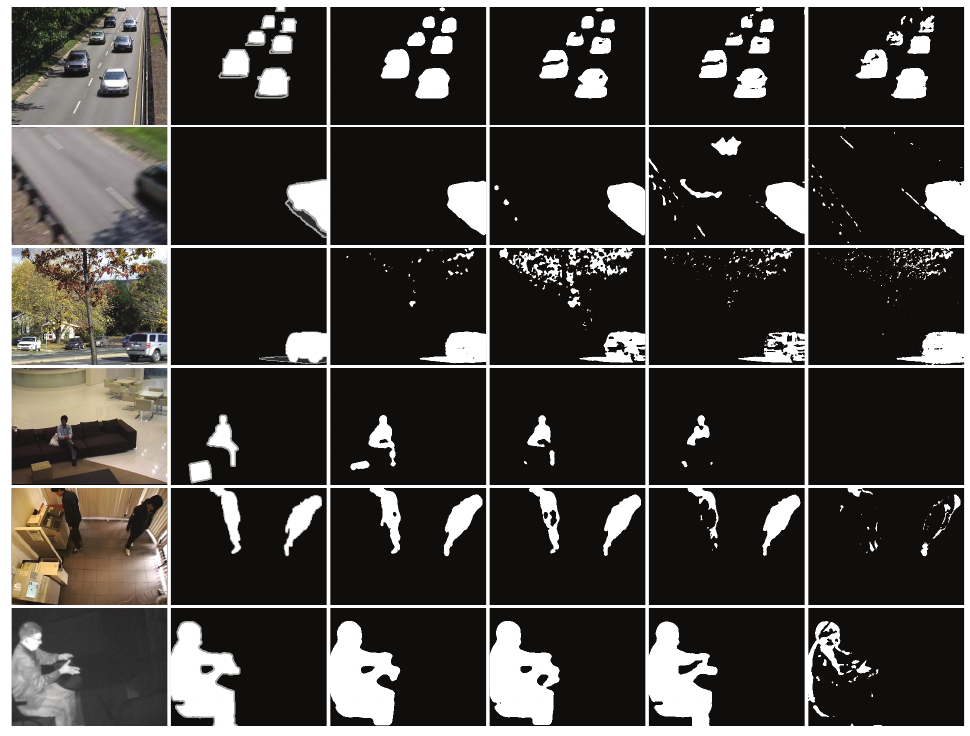
Figure 11. Qualitative performance comparison for various sequences (highway, traffic, fall, sofa, copyMachine and library, from top to bottom), reproduced with permission from [28], Copyright Mitsubishi Electric Research Laboratories, Inc., 2012. The first column is the input image, the second column is the corresponding ground-truth, gray pixels in the ground-truth indicate pixels which are not of interest, the third column shows the segmentation results of our method, the fourth column represents the segmentation results of the LOBSTER [26], the fifth column is the segmentation results of the ViBe [20], and the last column shows the output of the GMM [4]